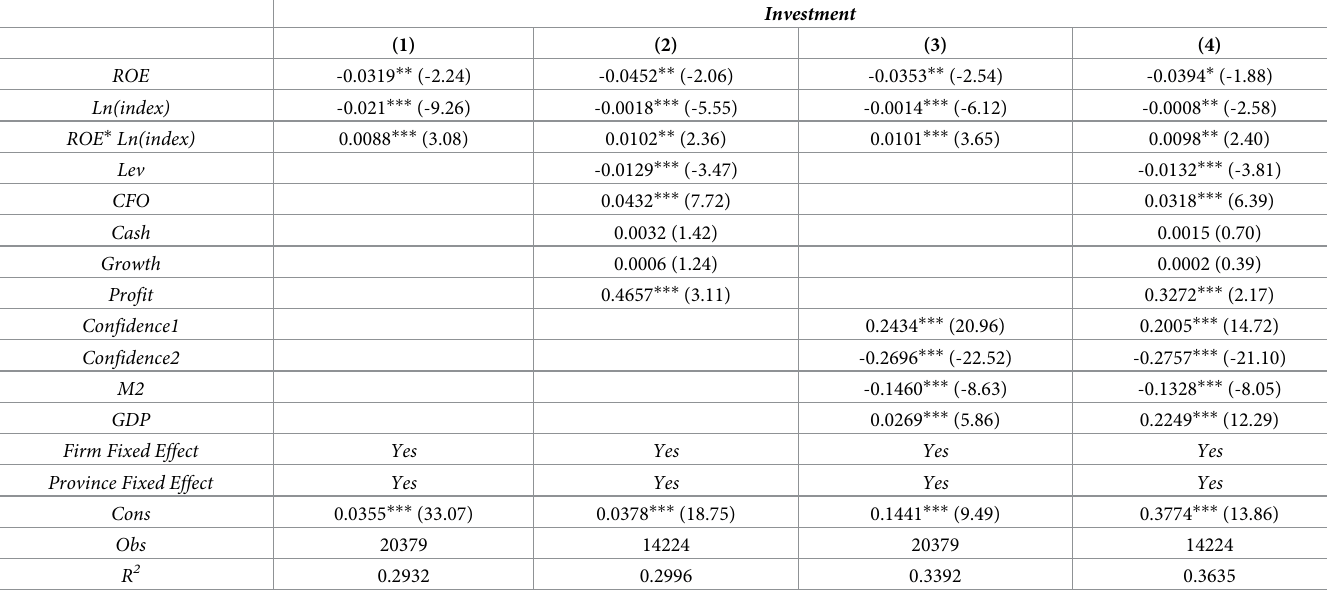
Table 4. Empirical results of SMEs’ fiscal and financial policies and investment